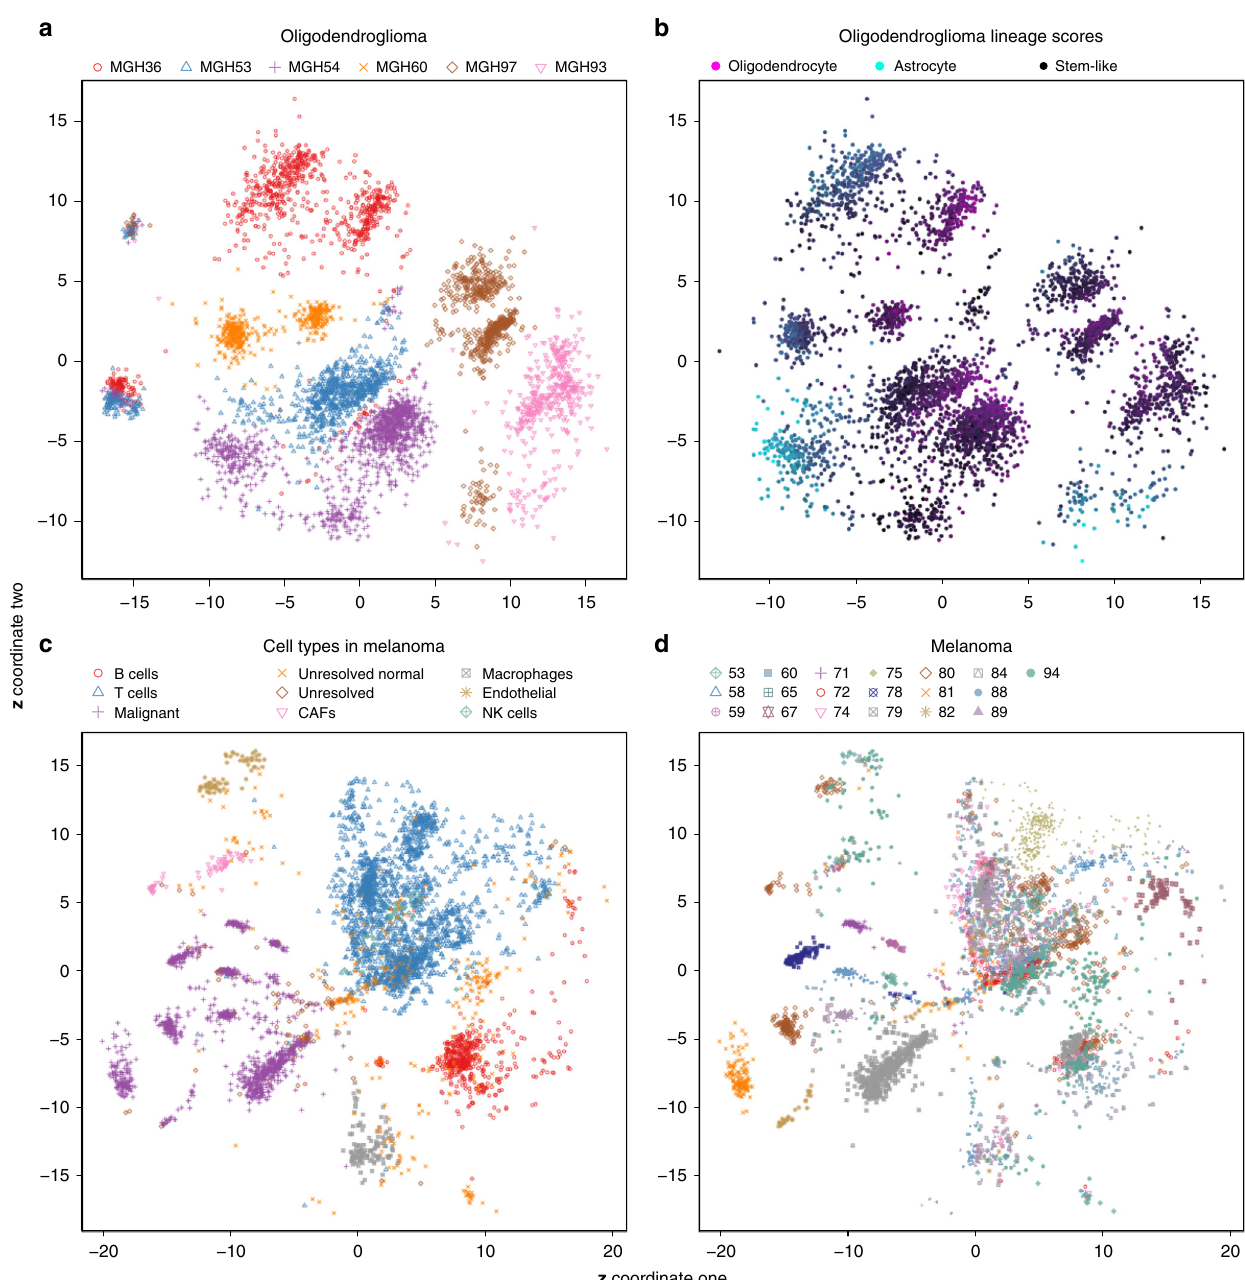
Fig. 5 scvis learned low-dimensional representations. a The oligodendroglioma dataset, each cell is colored by its patient of origin, b the oligodendroglioma dataset, each cell is colored by its linage score from Tirosh et al. 44 , c the melanoma dataset, each cell is colored by its cell type, and d the melanoma dataset, each cell is colored by its patient of